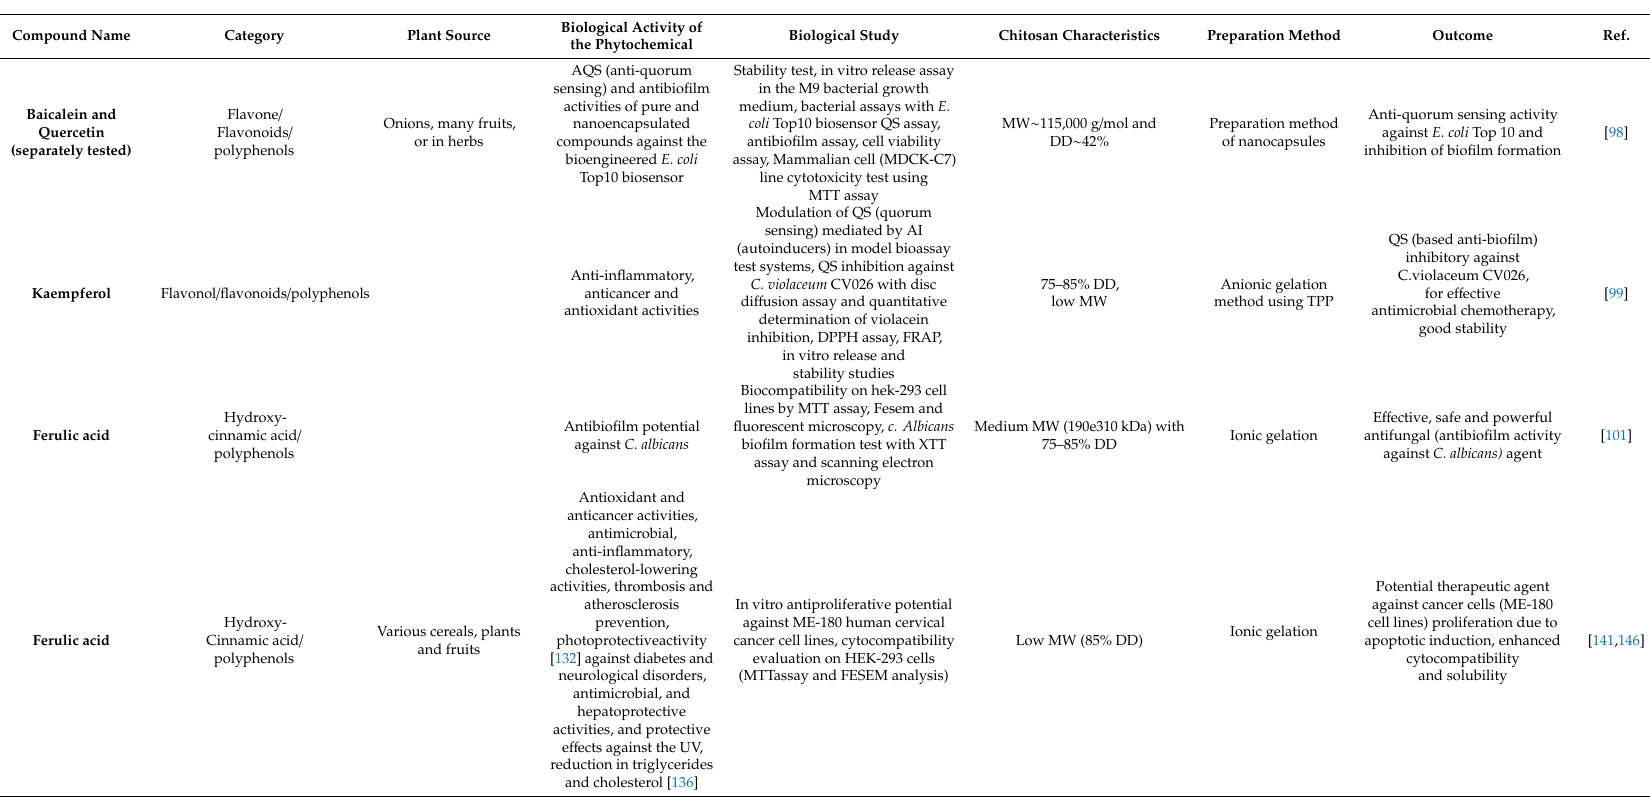
Table 3. Chitosan nanoparticles loaded with purified